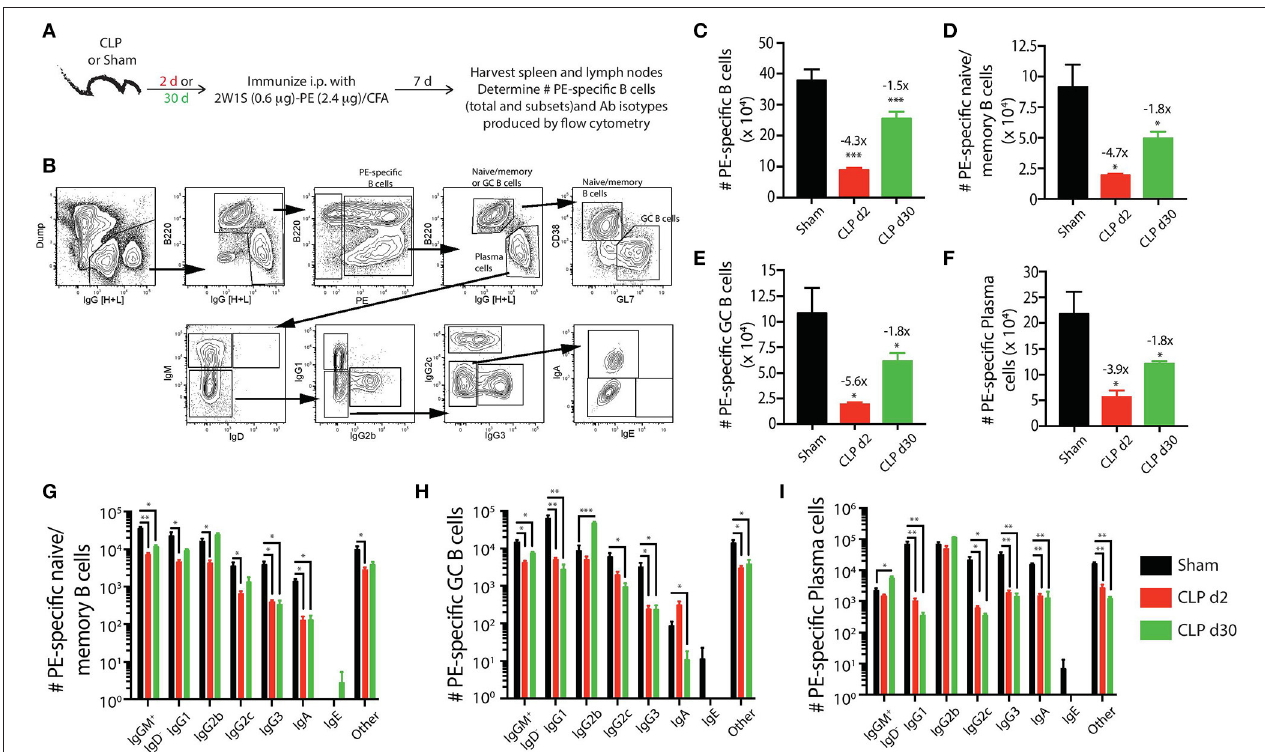
FIGURE 4 | Sepsis hinders B cell differentiation and class-switching during a CD4T cell-dependent B cell response. (A) Experimental design—mice underwent sham or CLP surgery and were then immunized on day 2 or 30 after surgery with 2W1S-PE/CFA i.p. Spleens and peripheral lymph nodes were harvested 7 days after immunization and combined. (B) Gating scheme used to identify PE-specific B cells, as well as the B220 hi IgG [H + L] lo CD38 + GL7 − naïve/memory B cells, B220 hi IgG [H + L] lo CD38 − GL7 + germinal center (GC) B cells, and B220 lo IgG [H + L] hi CD38 − GL7 − plasma cells. This representative scheme also shows the gating used to determine the extent of class switching within the plasma cell population, but similar gating was used on the naïve/memory and GC B cell populations. Representative flow plots are from a mouse immunized 2 days after sham surgery. The number of (C) total PE-specific B cells and PE-specific (D) naïve/memory B cells, (E) GC B cells, and (F) plasma cells were determined. Numbers above bars indicate the average fold change in number compared to sham-treated mice. (G–I) The naïve/memory B cell, GC B cell, and plasma cell subsets from the immunized mice were additionally subdivided based on the Ab isotype being produced. n = 5–7 mice/group. Statistical comparisons were made between sham mice and either CLP d2 or d30 mice, where * p < 0.05, ** p < 0.01, and *** p < 0.005. Data are representative of at least 3 independent experiments.